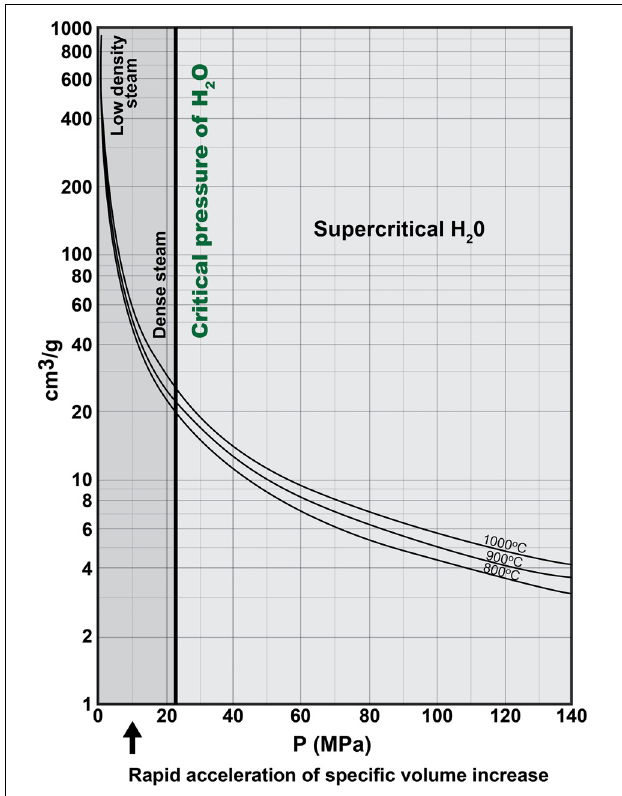
FIGURE 4 | Specific volume of water as a function of pressure and magma temperature. At pressures > 22 MPa (the critical point for water), exsolved water in high temperature magmas exists as a dense supercritical fluid. Exsolved water transitions from a supercritical fluid to a vapor or steam as the pressure decreases below the critical point. The change in physical state and decreasing confining pressure leads to an associated increase in the rate of specific volume growth, which further accelerates with decreasing pressure. (Modified from McBirney, 1963, Figure 2 , by annotating fields and labels; permission granted by Springer Nature License